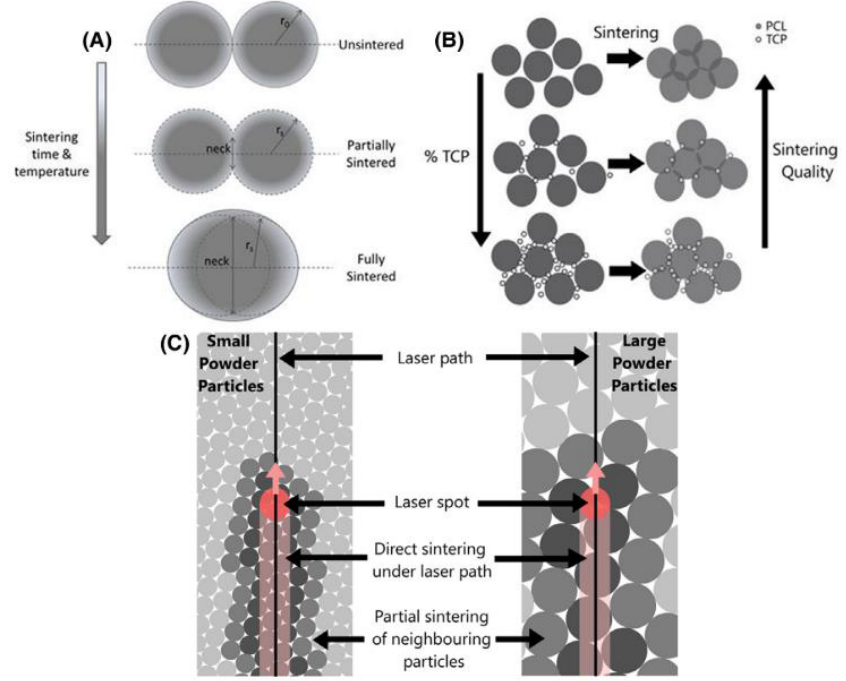
Figure 12. ( A ) Healing of individual polymer particles to form partially sintered and fully sintered material as a function of time and temperature. ( B ) Illustration of the effect of increasing filler content on the sintering of composite materials. An increase of filler content difficult the polymer sintering. ( C ) Schematic of sintering of powder particles with different particle sizes. Regions directly under the laser path are fully sintered, and heat is transferred to surrounding particles through contact points to form partially sintered regions. Higher partial sintering and lower porosity occurs for small particle sizes. Reproduced from [168].